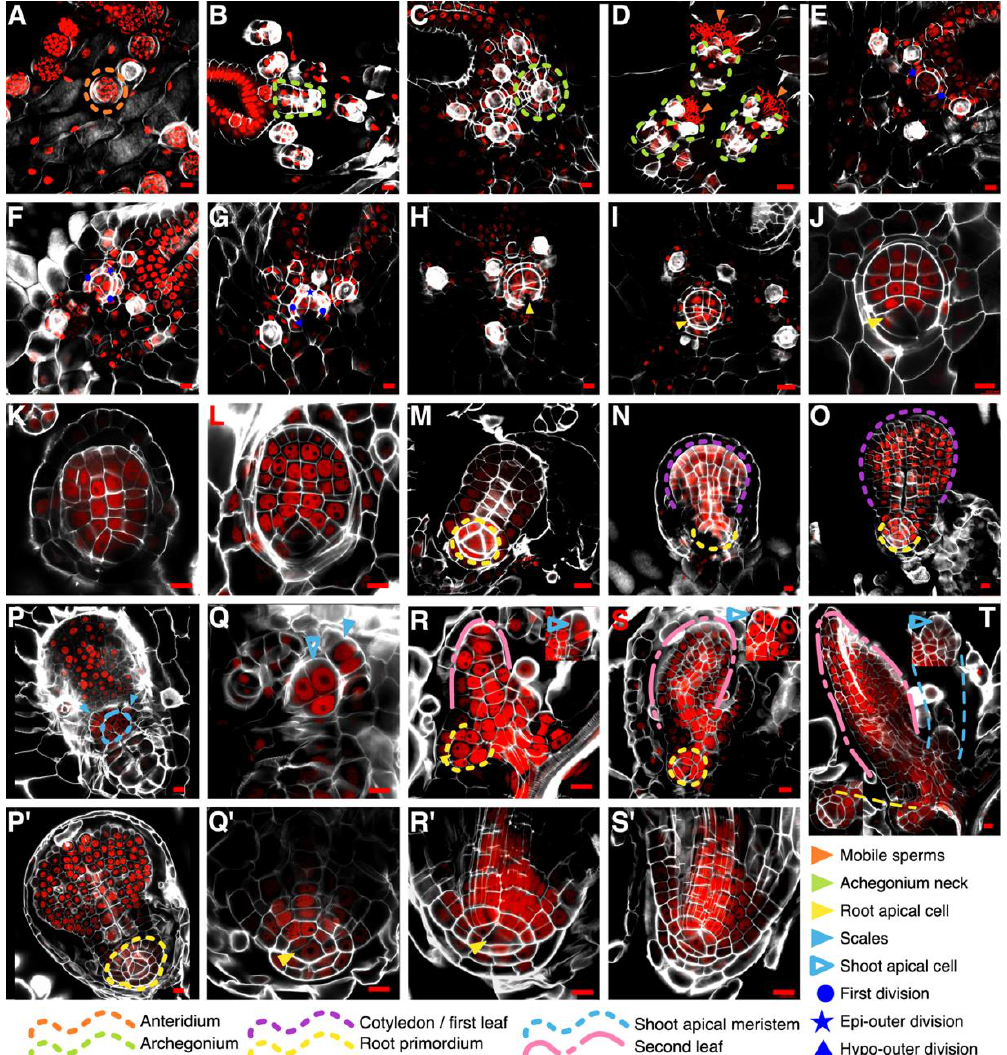
Figure 2. CLSM images of gametophyte-to-sporophyte transition and embryo development in Ceratopteris richardii . ( A ) Antheridia in a male gametophyte at 15 dps. ( B , C ) Archegonia in a hemaphrodite gametophyte at 15 dps. ( D ) Archegonial necks are reached by mobile sperms. ( E – G ) Early developmental stages of the embryo: two-celled embryo ( E ); epibasal division in an octant embryo ( F ); hypobasal division in an octant embryo ( G ). ( H – O ) The RAC is specified early in embryo development and a root primordium begins to form. Additionally, the first leaf grows until breaking the calyptra. ( P – T ; P’ – S’ ). Other components are also developing: shoot apical meristem (P,Q); first